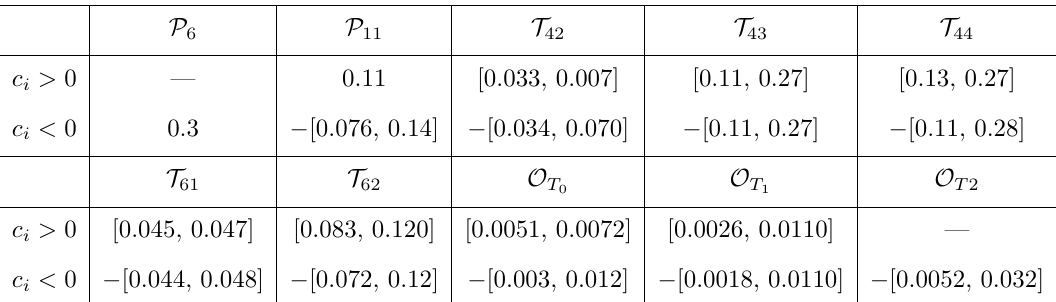
, O T , O T and O T . 62 1 2 2